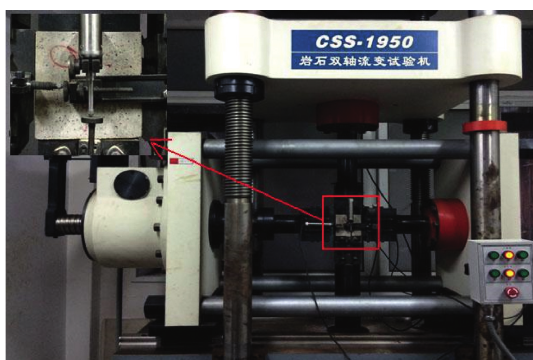
Figure 1: Snapshot of the test equipment.